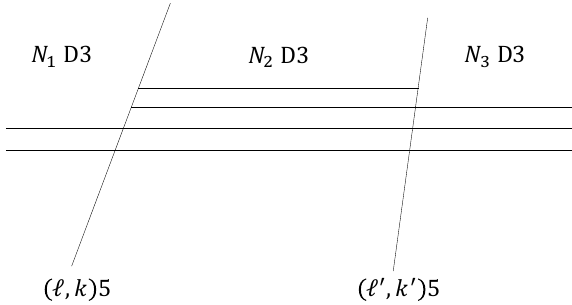
Figure 7 . The brane configuration of the local theory for general 5-branes. Note that the horizontal direction is not identified on the both ends unlike figure